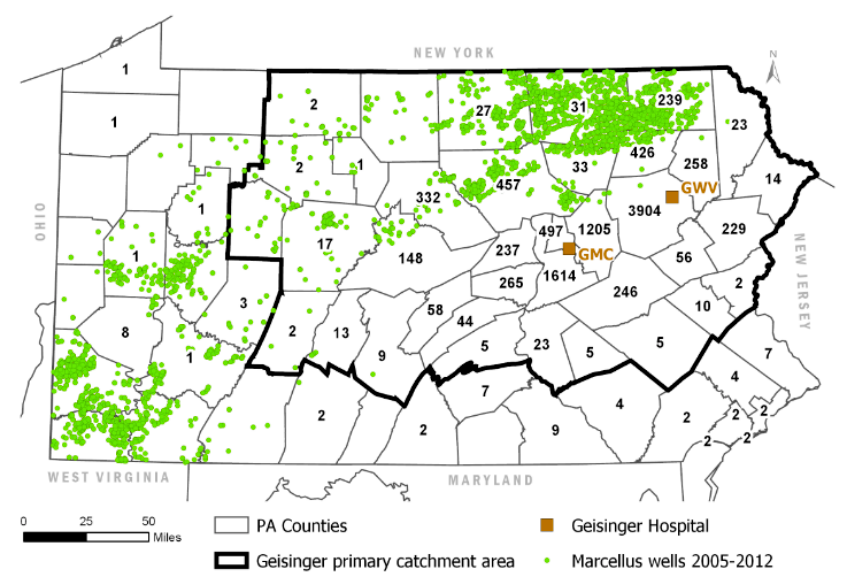
Figure 1. Adapted from Casey et al. [2], showing the Geisinger primary catchment area relative to the location of unconventional wells spudded or in production during the period 2005–2012. The numbers within the county boundaries describe the distribution of the study population ( n = 10,496) across the state and indicate the number of babies born to mothers living in each county. GMC = Geisinger Medical Center, GWV = Geisinger Wyoming Valley. Figure was regenerated with data available through Shell’s licensing agreements with Esri and IHS Markit Ltd.